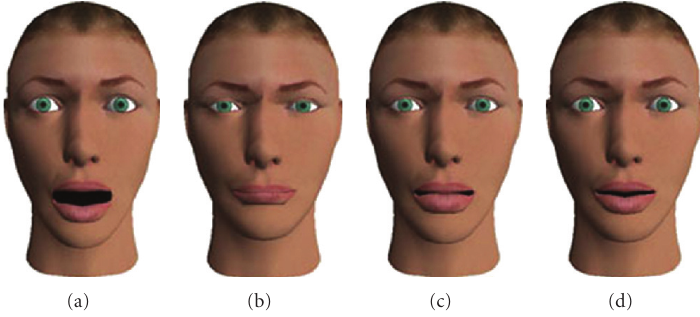
Figure 1: (a) Surprise, (b) anger, (c) transition between surprise and anger using simple averaging (interpolation), and (d) blending based on emotion parameters and their associated facial actions which is more “perceptually